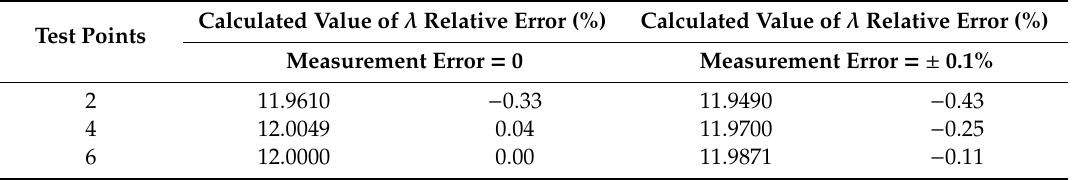
Table 1. The value of λ and the relative error.